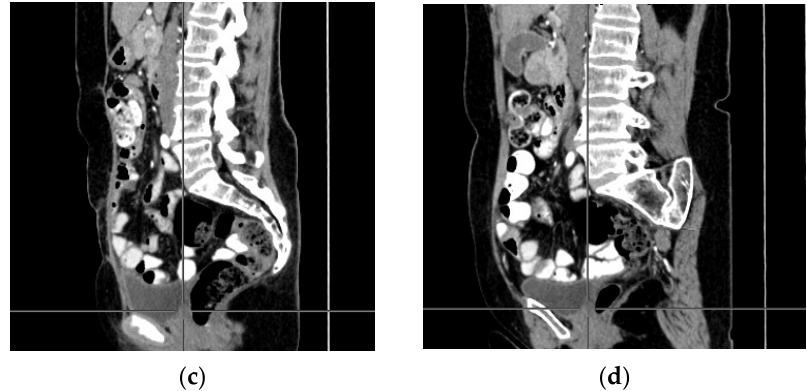
Figure 2. ( a – d ) CT scans performed at the beginning of olaparib treatment .